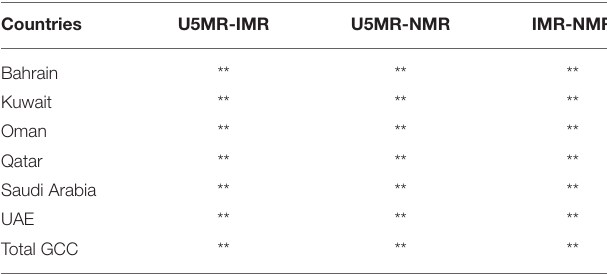
TABLE 1 | The significance level ( p -values) of correlation coefficients.